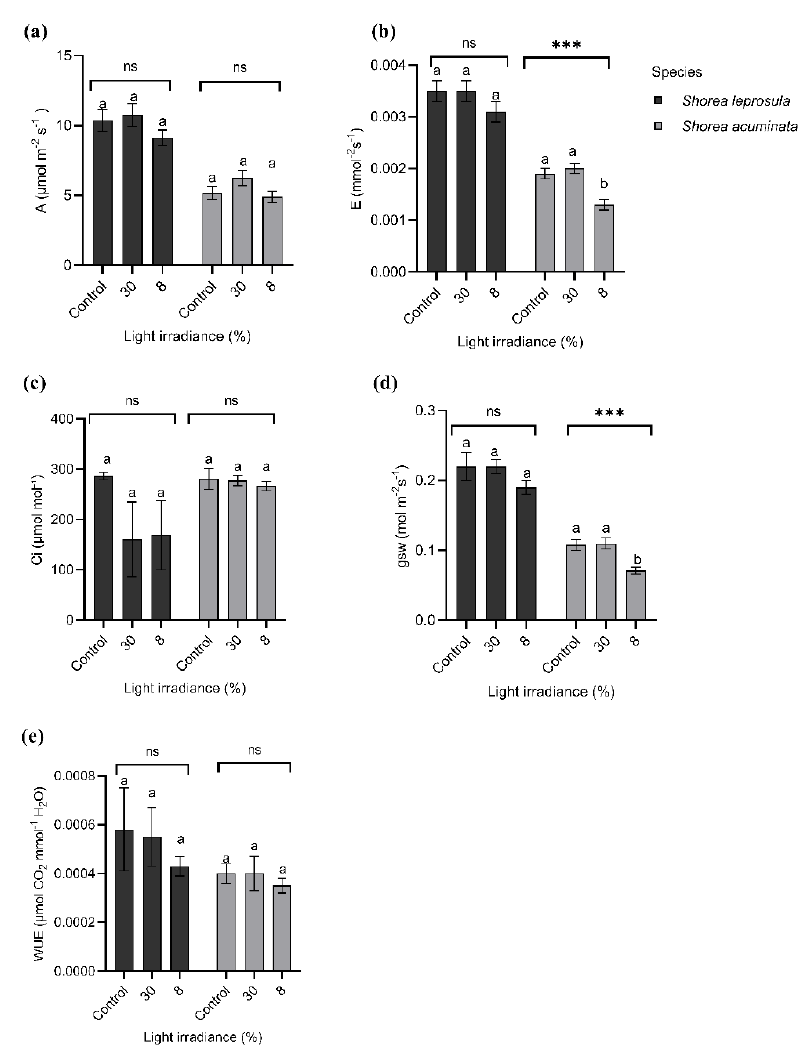
Figure 5. Shorea leprosula Miq. and Shorea acuminata Dyer gas exchange characteristics in different light irradiances (mean ± SE); ( a ) photosynthesis rate (A, µ mol m − 2 s − 1 ); ( b ) transpiration rate (E, mmol − 2 s − 1 ); ( c ) intercellular carbon concentration (Ci, µ mol mol − 1 ); ( d ) stomatal conductance (g sw , mol m − 2 s − 1 ); ( e ) and water-use efficiency (WUE, µ mol CO 2 mmol − 1 H 2 O). Alphabets denote significant differences between light irradiance treatments with *** indicating significant at p < 0.001, respectively; ns =